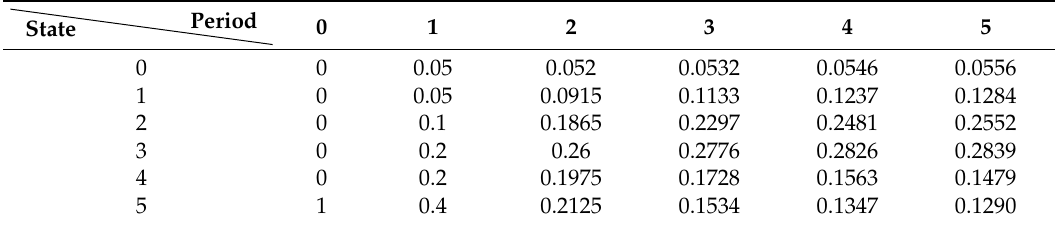
Table A1. Probability distribution of component 1 using the SMV